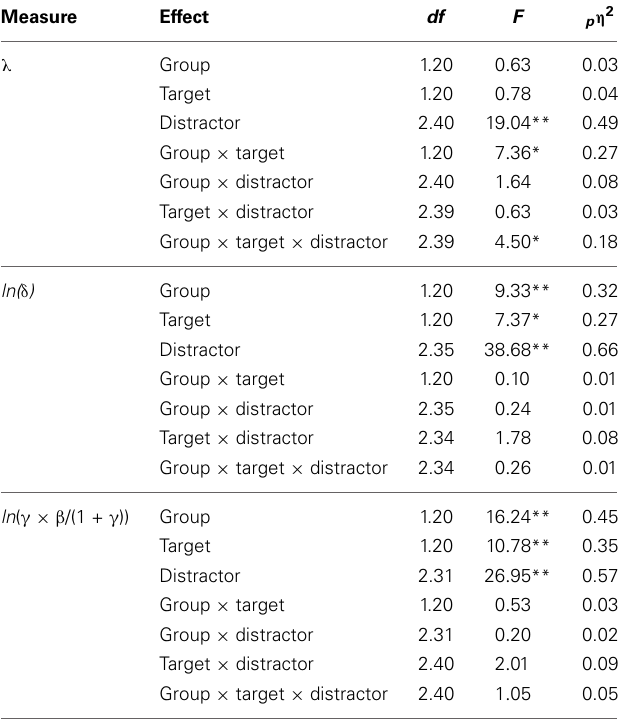
Table 3 | ANOVA results for the three measures of interest: overall error rate [ λ ], log initial uncertainty time [ ln ( δ )], and log home-in time [ ln ( γ × β/ (1 + γ